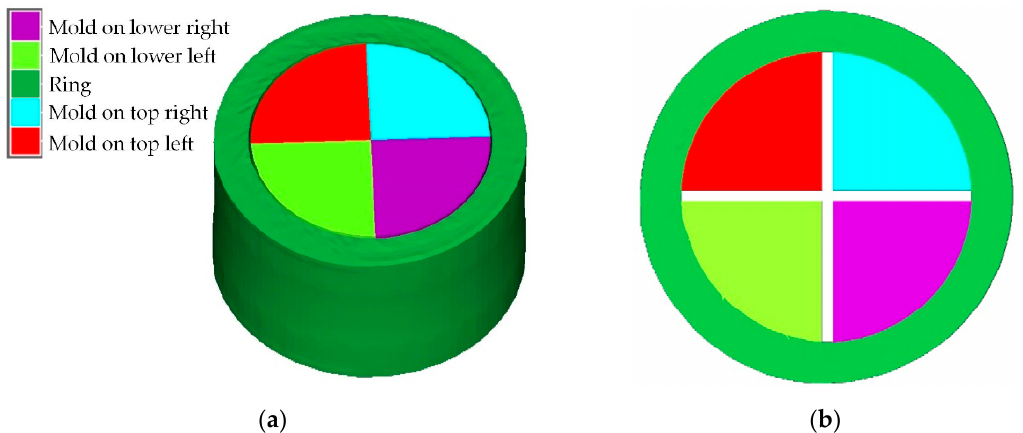
Figure 6. Residual ‐ stress homogenization by expansion method: ( a ) finite ‐ element model of Figure 6. Residual-stresshomogenizationbyexpansionmethod: ( a )finite-elementmodelofhomogenization; homogenization; ( b ) model ‐ position relation. ( b ) model-position